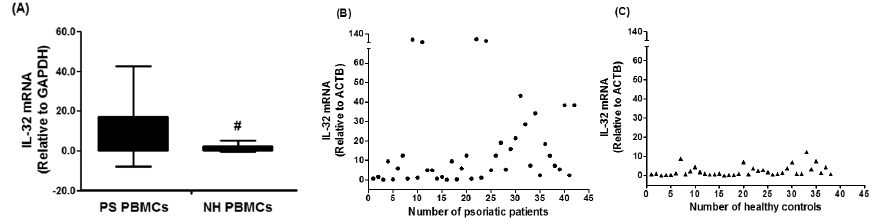
Figure 1. Gene expression of human interleukin (IL)-32 in the peripheral blood mononuclear cells (PBMCs) of chronic psoriatic patients. Data in column chart ( A ) and scattered data points chart ( B , C ). Expression of IL-32 mRNA was determined by real-time qRT-PCR using either GAPDH or ACTB as an endogenous control in the comparative ∆∆ CT method. PS PBMCs, psoriatic patients PBMCs. NH PBMCs, normal human PBMCs; Data are representative (mean ± SD) of experiments with PBMCs obtained from psoriatic patients ( n = 42) and normal healthy subjects ( n = 38). # p = 0.001 versus PS PBMCs. Comparison analysis was performed using a two-tailed t-test using Mann–Whitney analysis.